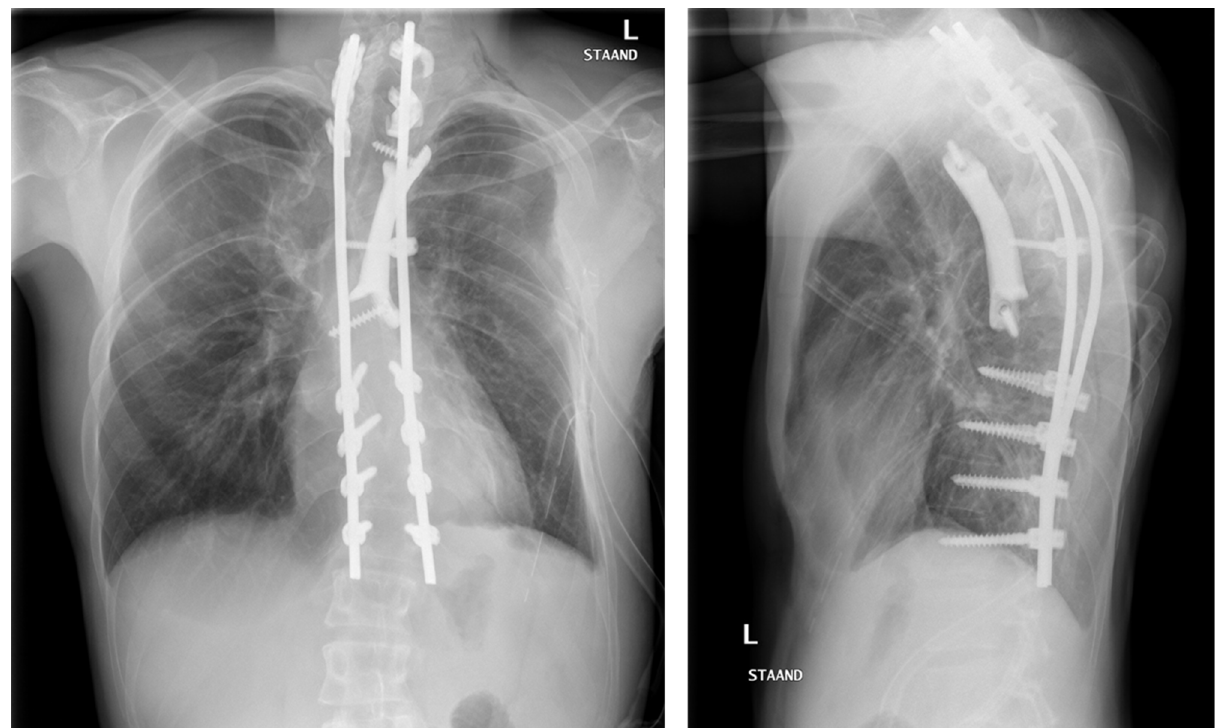
Figure 12. Case 3: Anterior-posterior ( left ) and sagittal ( right ) radiographs postoperation.